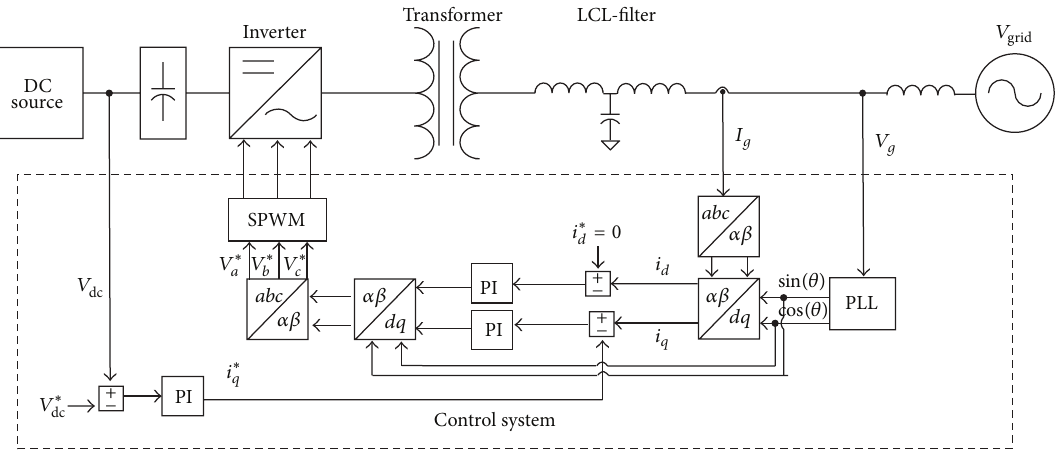
Figure 4: Experimental setup and control system overview for the grid-connected CC-VSI.